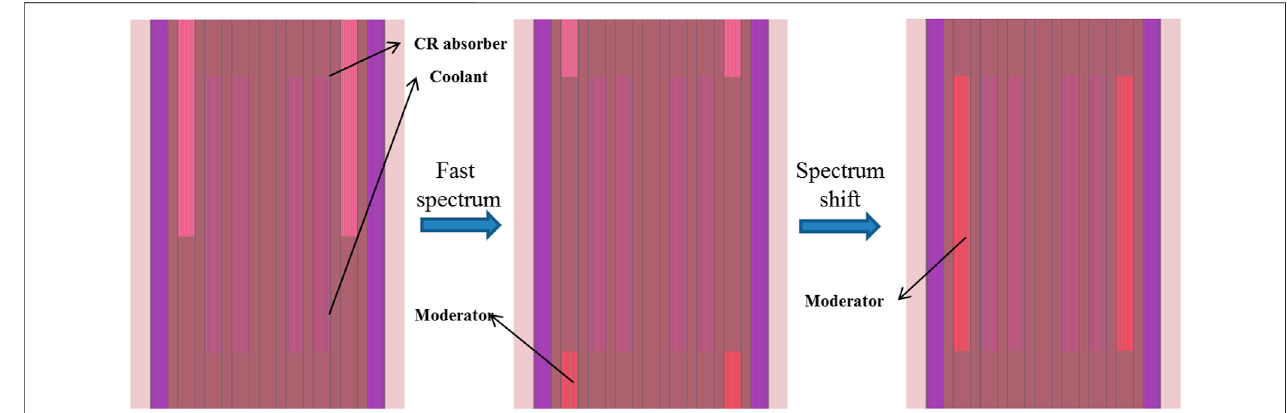
FIGURE 9 | Detailed axial cut in the spectral-shift rod withdrawing